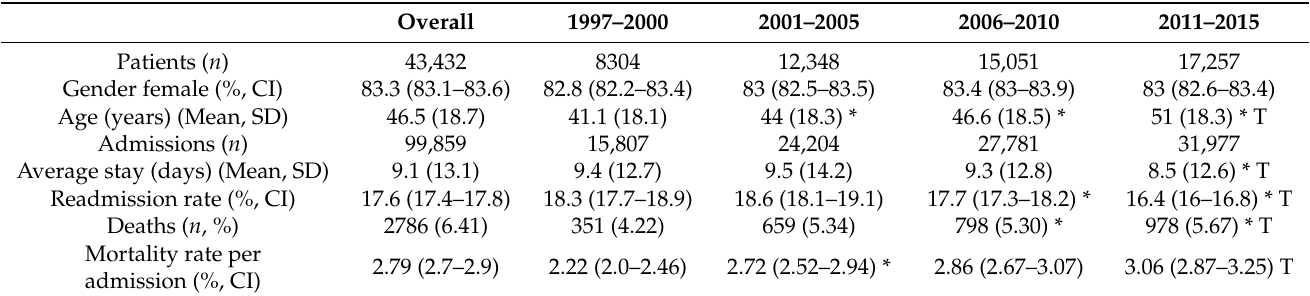
Table 1. Main demographic characteristics in SLE hospitalized patients.